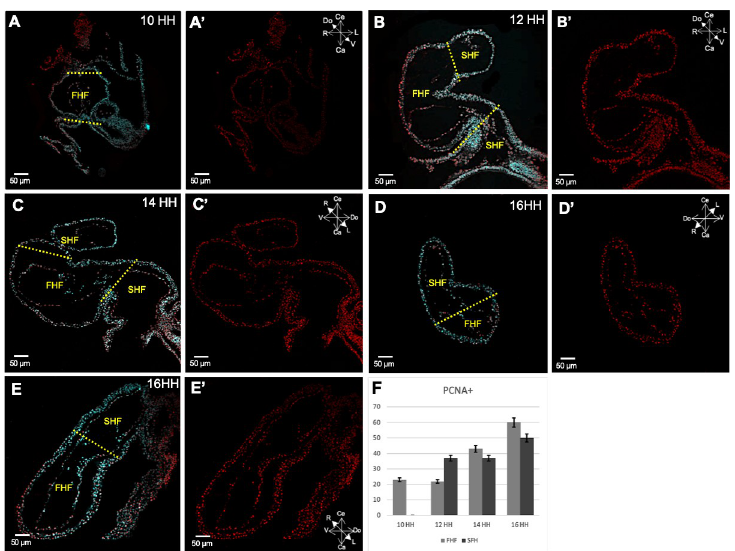
Fig 4. PCNA distribution patterns in the cardiac tube throughout torsion and looping. (A, A 0 ) Frontal view of a section of a straight heart tube (HH10). A small number of PCNA-positive fluorescent red cell nuclei are observed in the FHF delimited by two yellow dotted lines; (B, B’) Frontal view of a section of a C looped heart (HH12); (C, C’) left sagittal view of an S looped heart (HH14). Increased number of PCNA-positive fluorescent red cell nuclei are observed in cardiac segments derived from SHF; (D, D’). Right and left views of a section of a U looped heart (HH16). Notable increase in PCNA-positive fluorescent red cell nuclei in heart structures derived from both the first and second heart fields. (E) Graphical representation of the percentage of PCNA-labeled cells with respect to the total number of cells constituting each heart field at torsion and looping stages. Abbreviations: FHF, first heart field; SHF, second heart field.